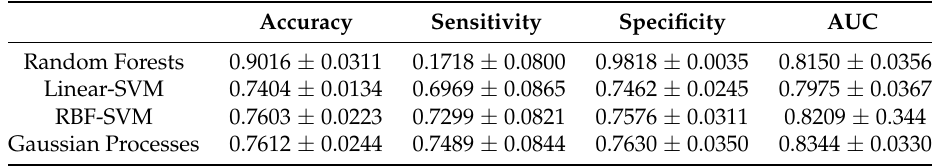
Table 8. AUC, accuracy, sensitivity and specificity related to the dark-lesion detection (microaneurysms and hemorrhages) on DIARETDB1 database for each classification method studied in this work using a decision threshold δ =